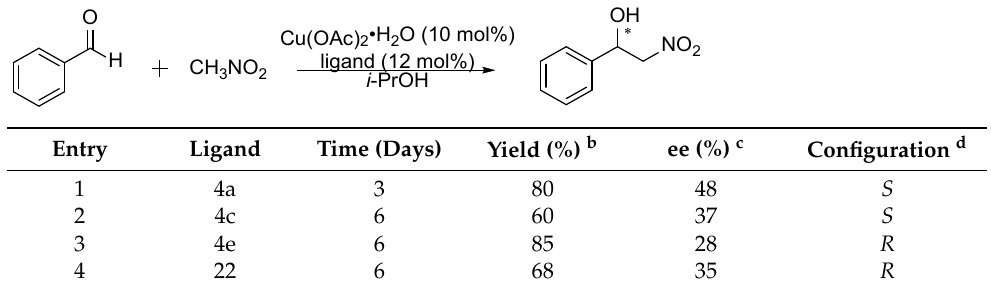
Table 3. Nitroaldol reaction with benzaldehyde, catalyzed by selected N-oxides a .